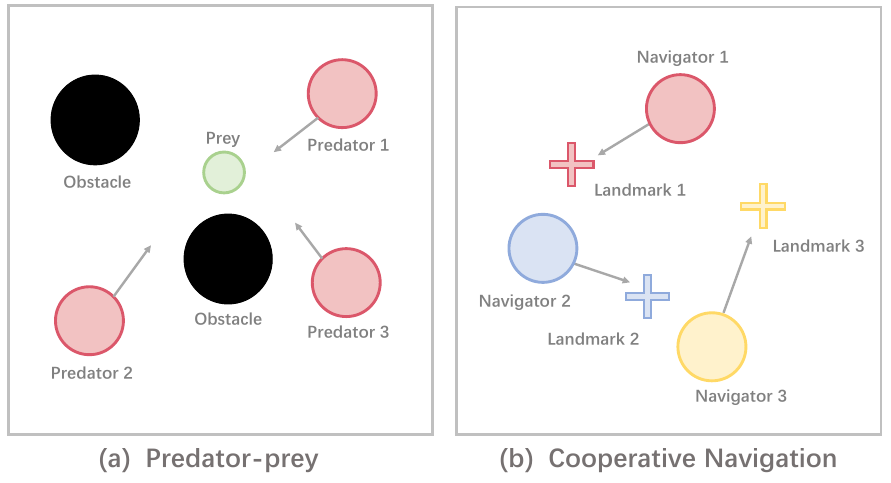
Figure 3. An example of the MPE benchmark. ( a ) Three predators try to capture prey to obtain rewards. ( b ) Three navigators aim for reaching the nearest